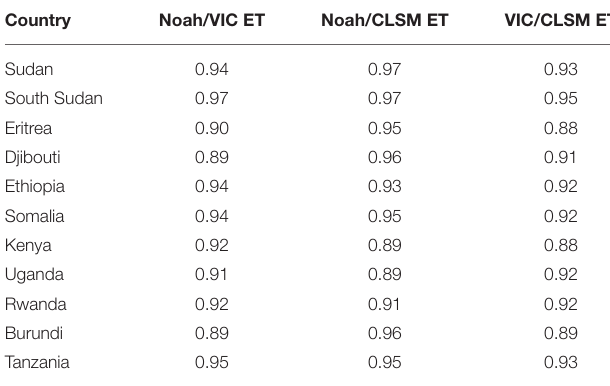
TABLE 1 | International Geosphere Biosphere Program (IGBP) land cover classes. Land cover index